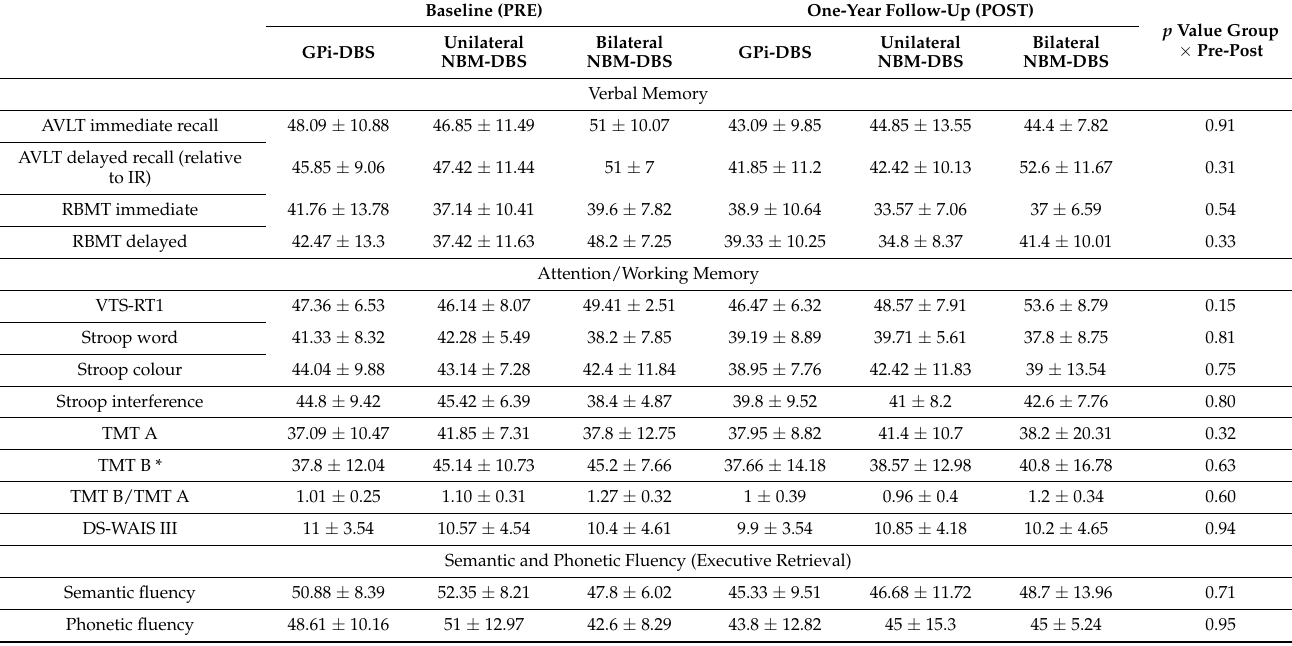
Table 3. Neuropsychological outcomes at baseline and following one year of DBS. Baseline (PRE) One-Year Follow-Up (POST)